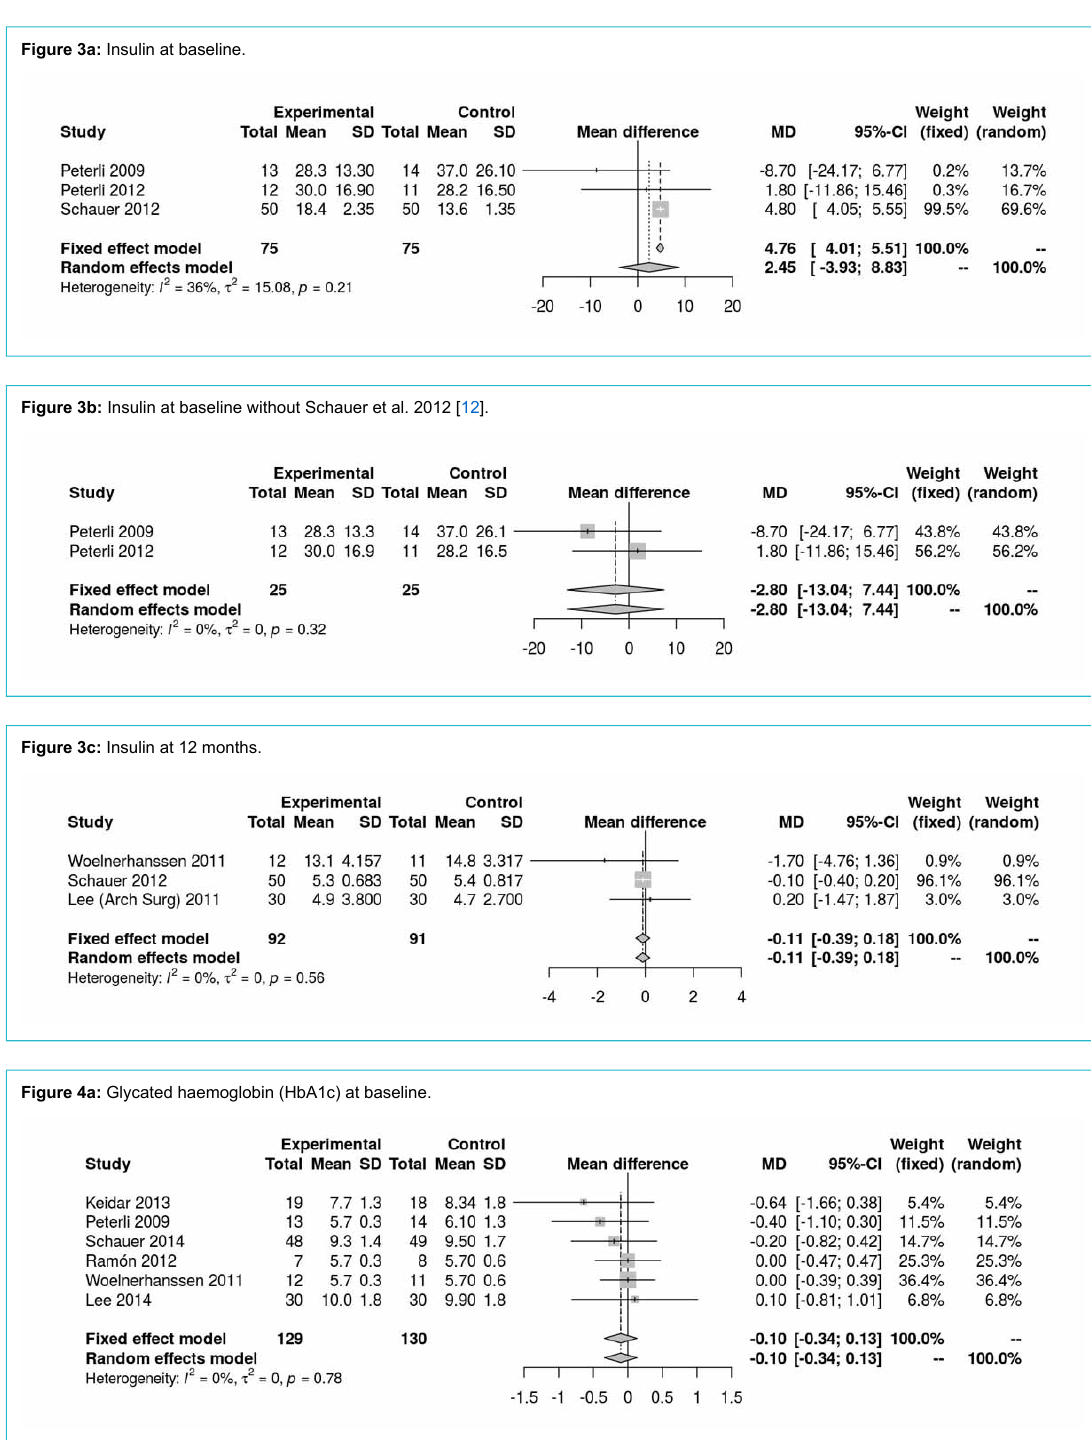
Figure 3a: Insulin at baseline.